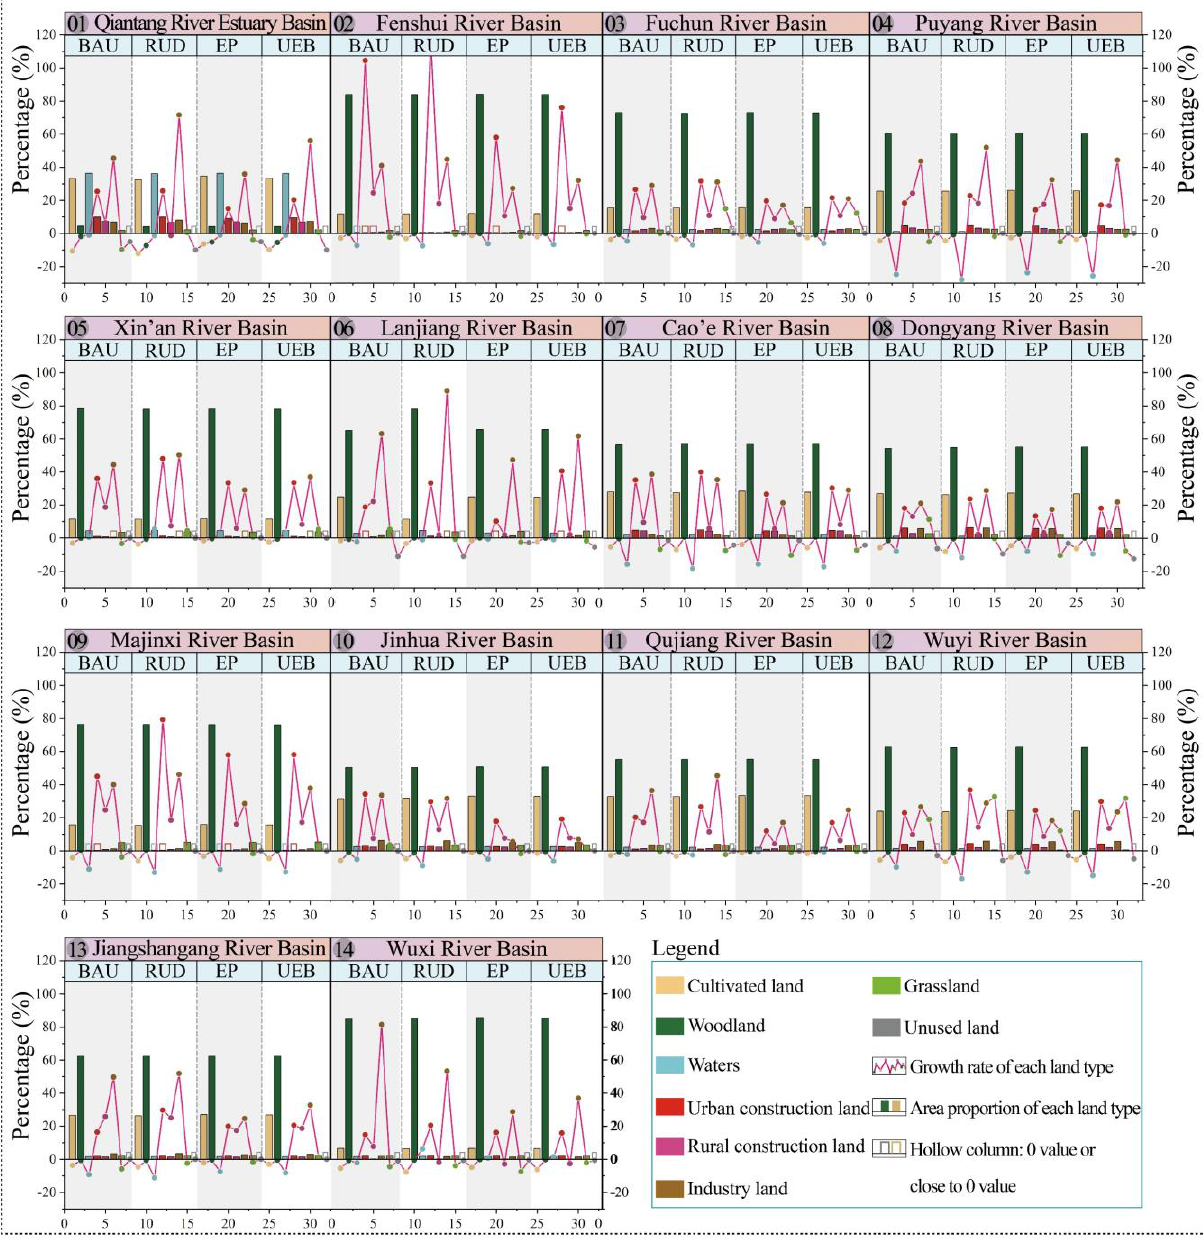
Figure 9. Land composition and change degree of each subbasin in different scenarios.